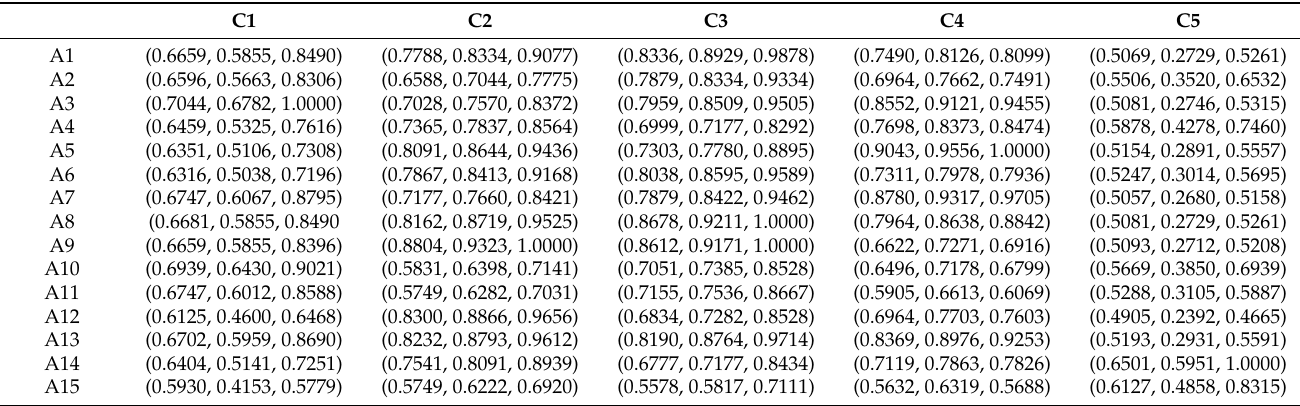
Table 8. Weighted normalized matrix for the